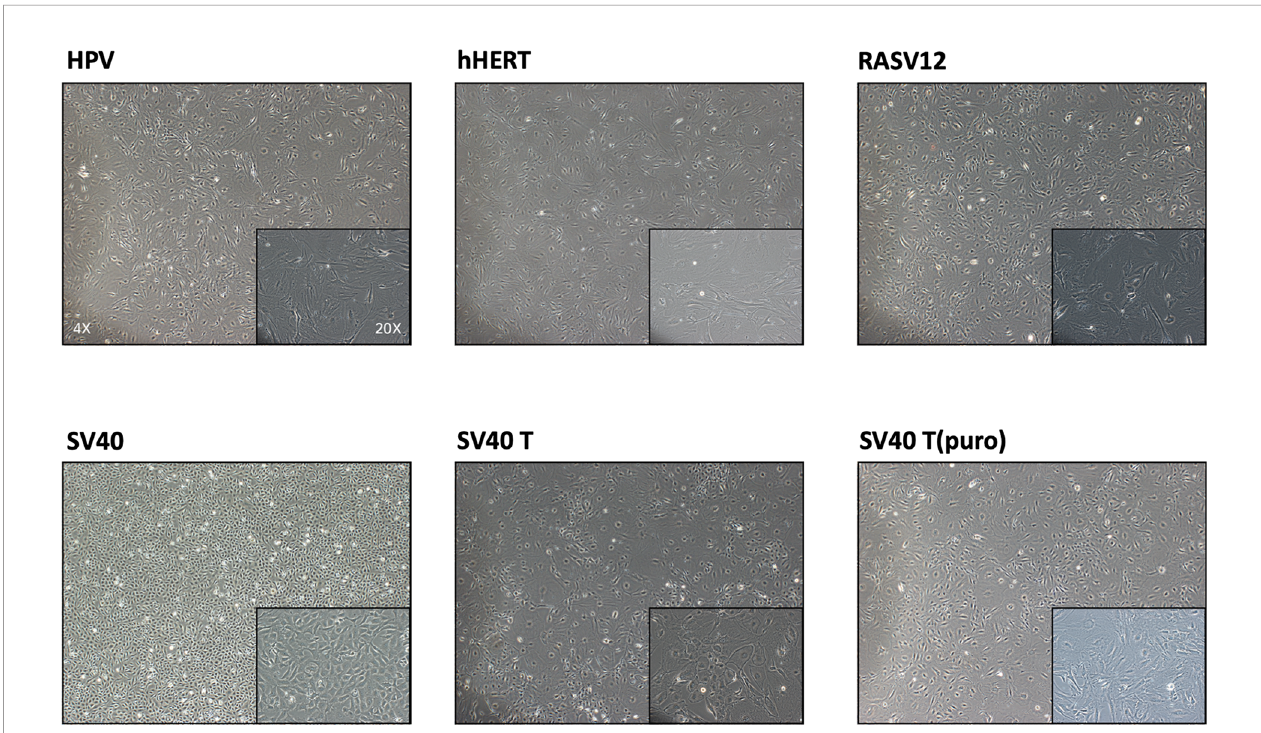
FIGURE 6 | Morphology of mouse pulmonary microvascular endothelial cells (MPMECs) transduced by different lentiviruses. Illustration of the second transduction of MPMECs using different lentiviruses (bright fi eld phase-contrast images). Only the Lenti-SV40 group can maintain the “ cobblestone-like ” morphology of endothelial cells when cultured as a monolayer and proliferate